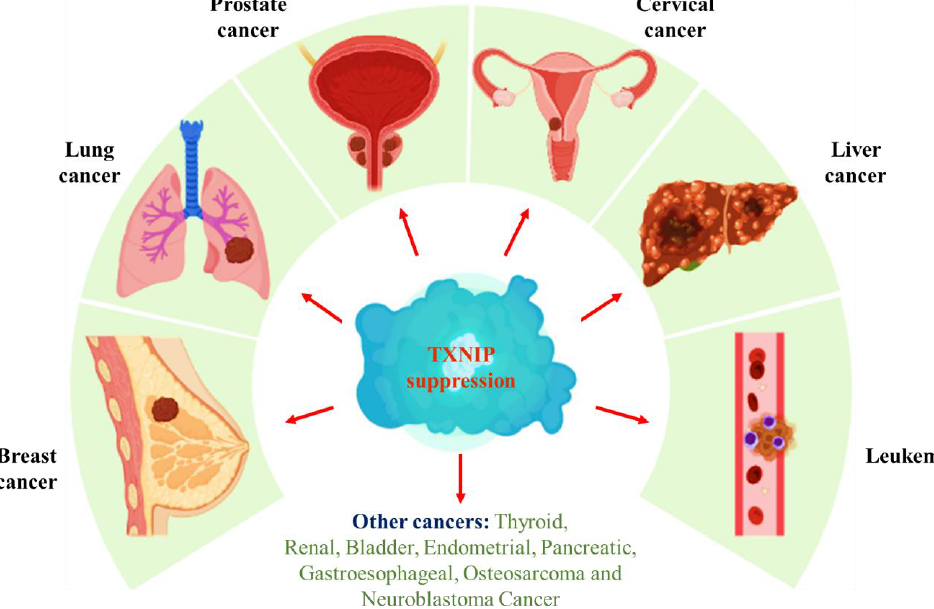
Figure 2. The systematic illustration of TXNIP suppression in cancer progression.